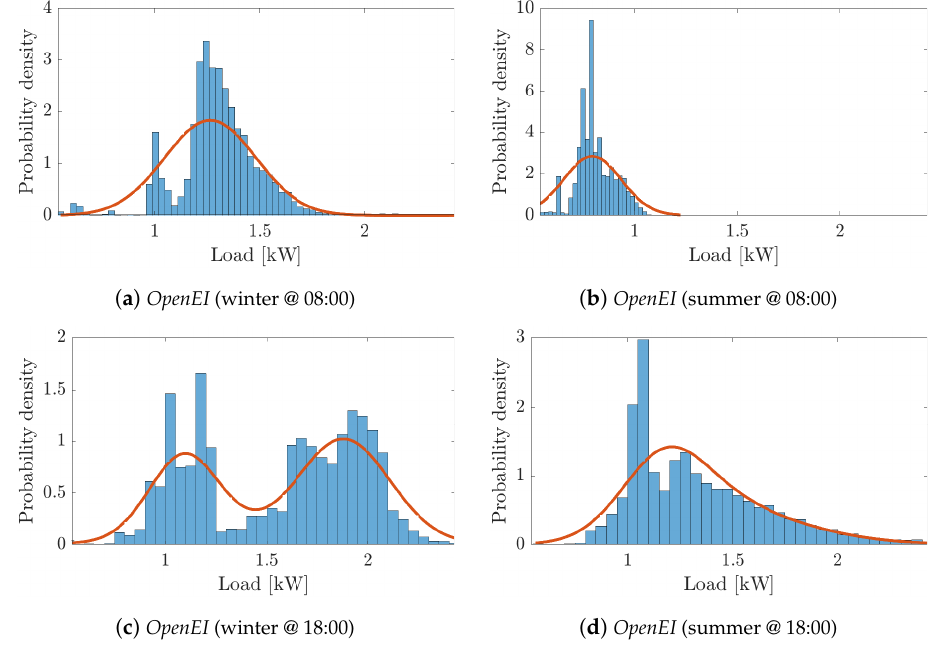
Figure 3. Histograms of the OpenEI original LPs and PDFs of the corresponding SLPs (solid lines) at two different times of the day (8:00 and 18:00) in winter and summer, respectively. Histograms computation and GMM PDFs fitting are performed using the same amount of data and refer to the most populated cluster.